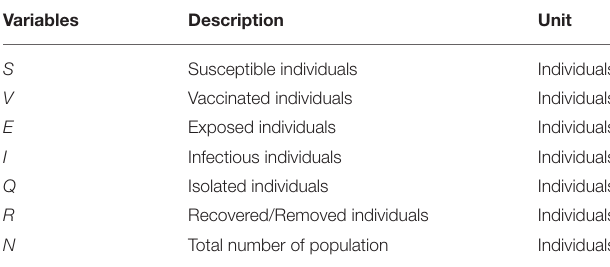
TABLE 1 | Variables in the SEIQRV model of